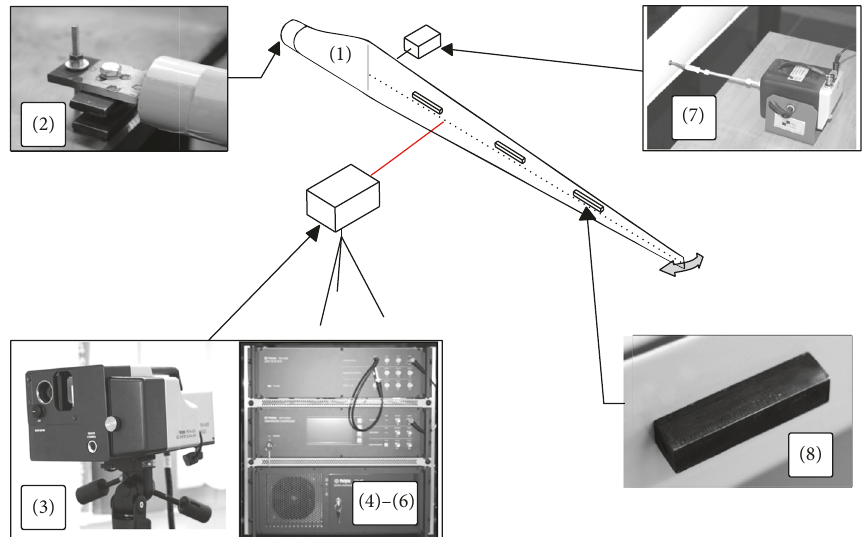
Figure 6: A scheme of a laboratory stand: (1) rotor blade; (2) blade fixing; (3) head of laser scanning vibrometer; (4) signal amplifier; (5) signal generator; (6) computer; (7) shaker; (8) model of damage.